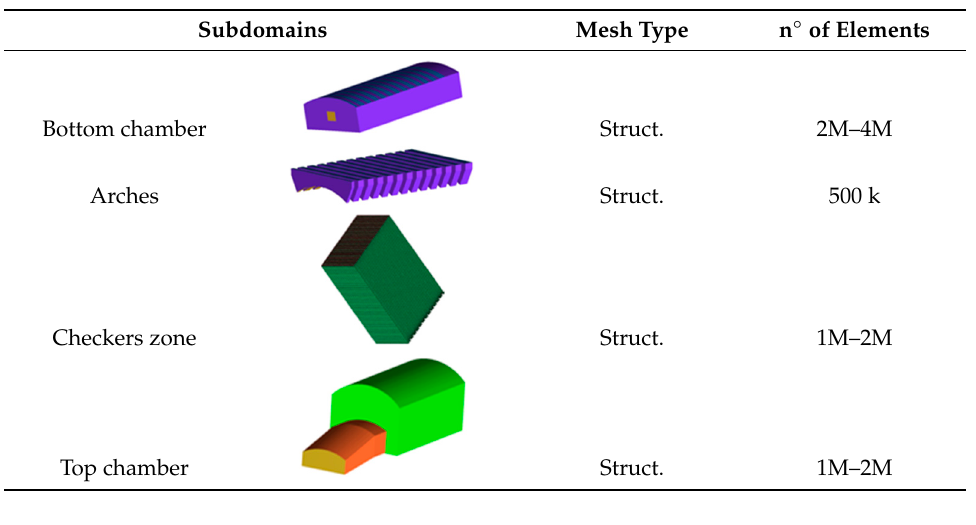
Figure 4. Tested regenerative chambers. Table 1. Geometrical parameters of the tested regenerative chambers. Table 2. Subdomains and mesh characteristics.